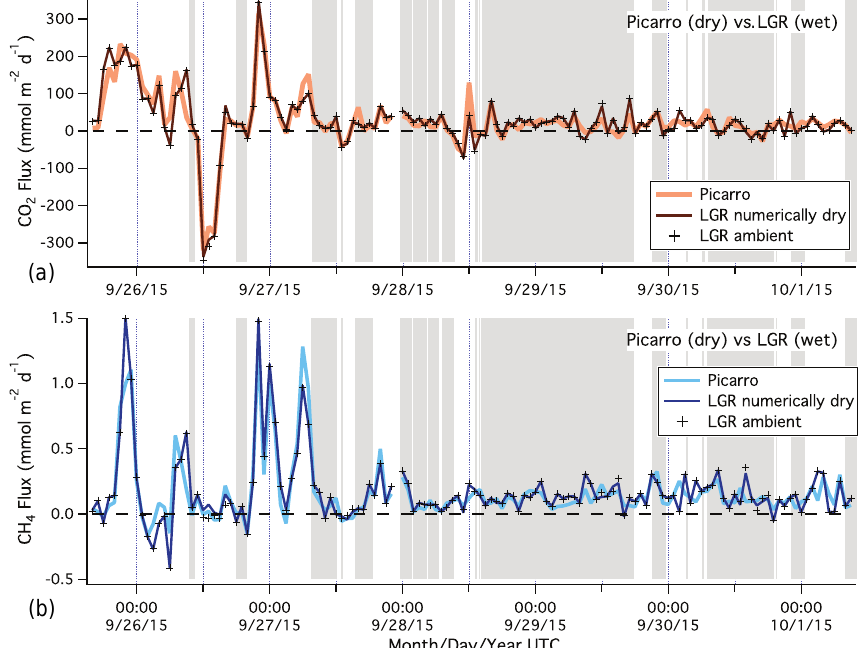
Figure 2. Time series of CO 2 (top) and CH 4 (bottom) fluxes. Picarro sampled after a dryer, while LGR sampled ambient (moist) air. “LGR ambient” indicates flux prior to the numerical H 2 O correction. The shaded region indicates the wind sector between 45 and 80 ◦